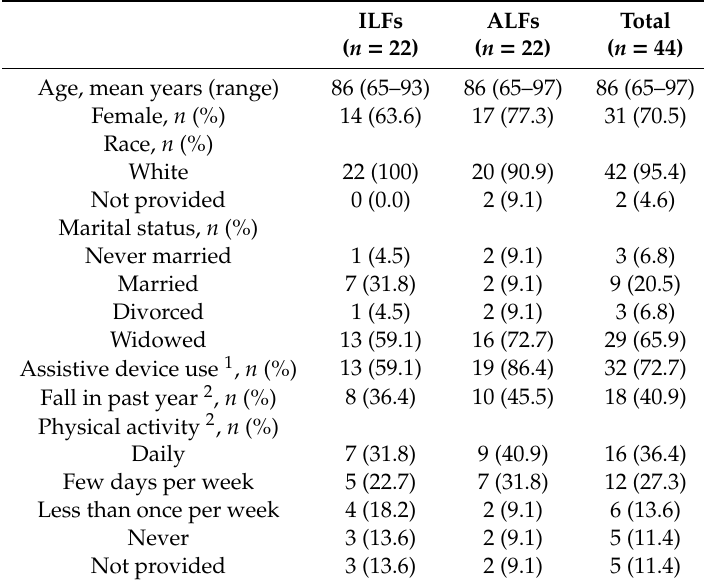
Table 1. Focus Group Participant